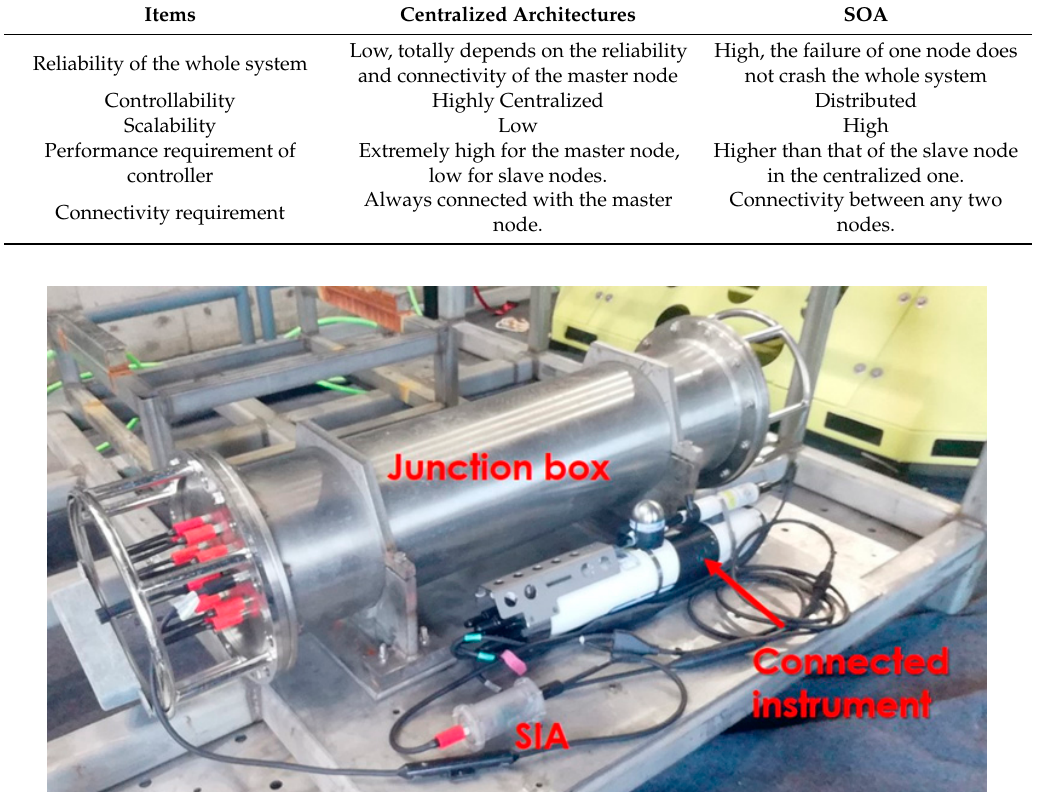
Figure 5. Using the SIA as middleware between a junction box and an instrument.